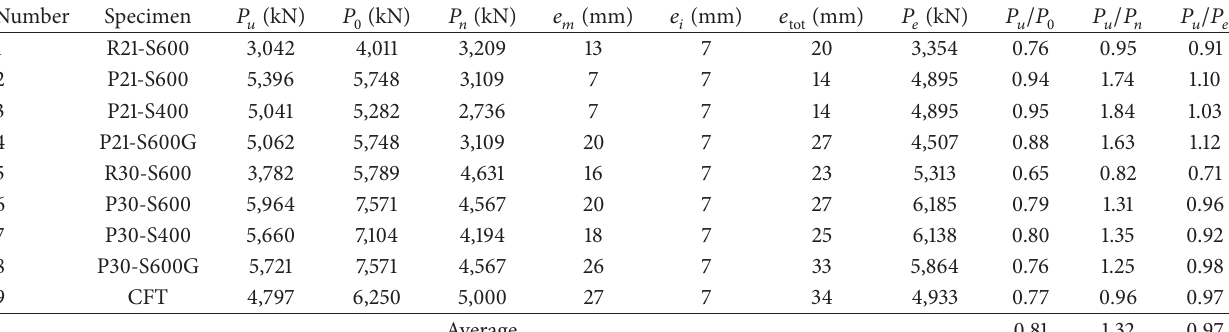
Figure 4: Axial load-deformation responses of test specimens. Table 5: Comparison of test results and calculated